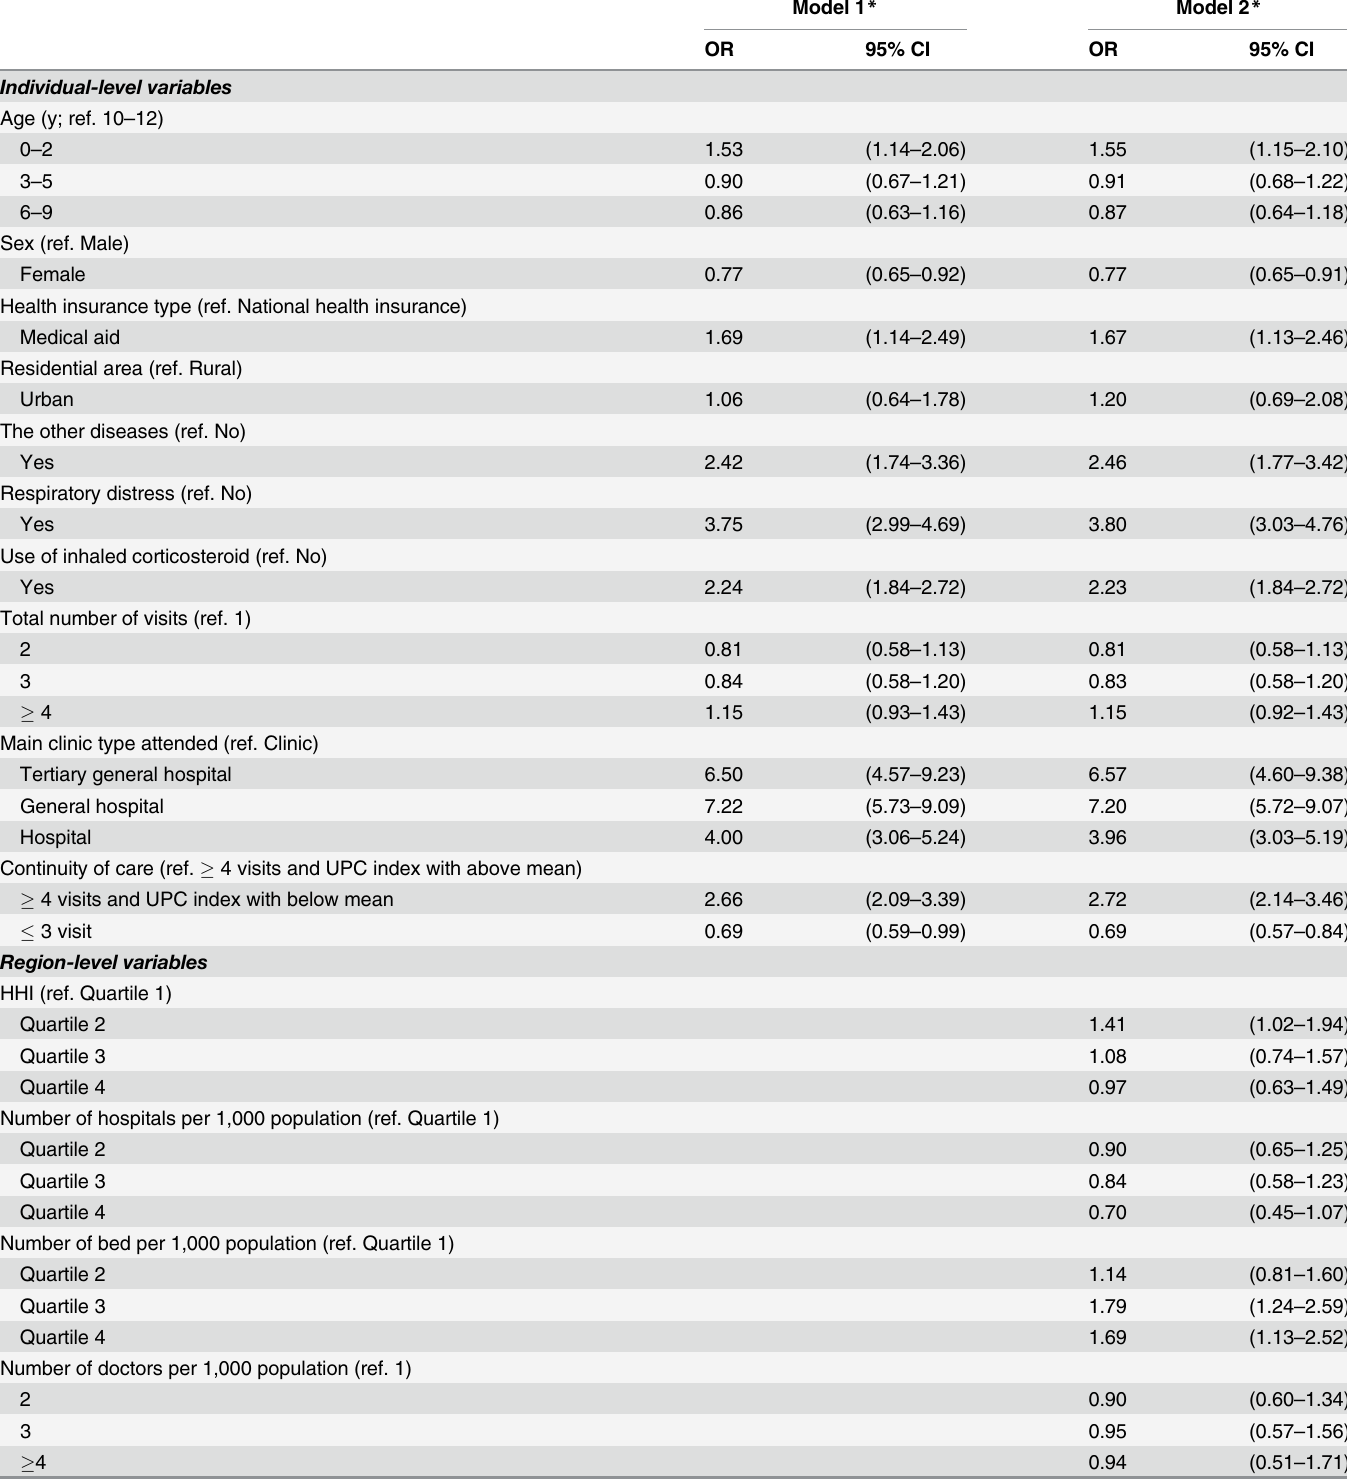
Table 4. ORs and 95% CIs for hospital admissions: results of multi-level logistic regression models (N =